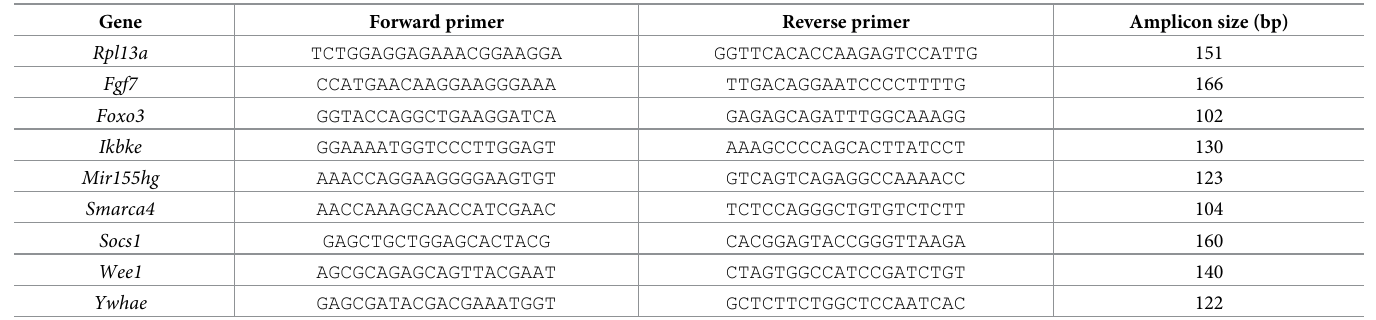
Table 1. Primers used for real-time